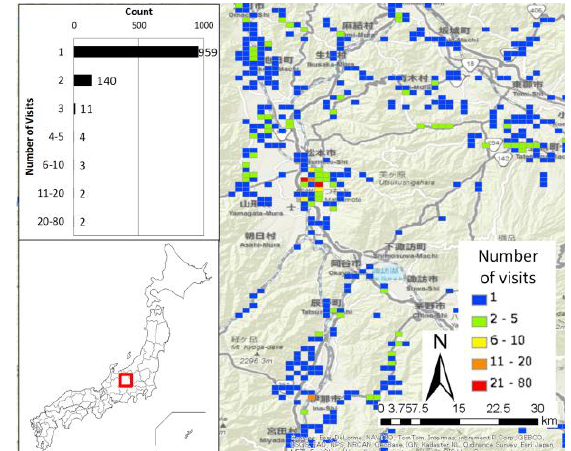
Figure 3. Numbers of visit in each Regional Mesh of a user who has the most number of stay locations in 2012